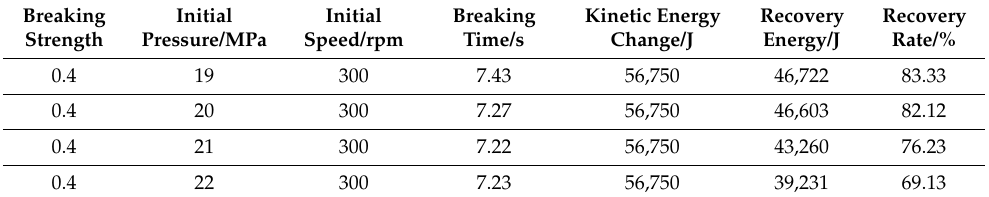
Table 1. Experimental